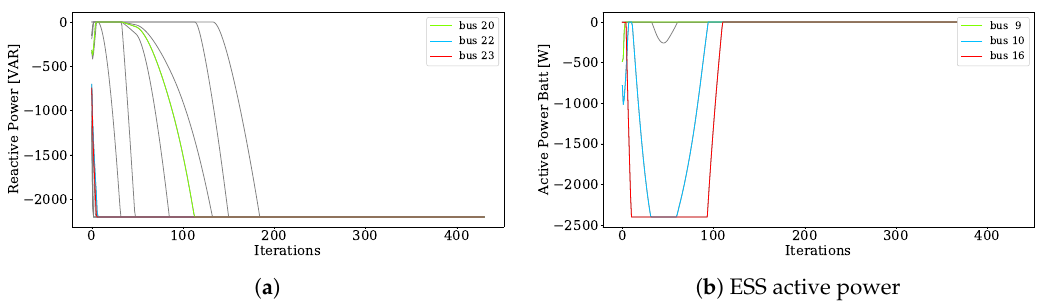
Figure 14. DG and ESS power injection in scenario without virtual nodes. ( a ) DG reactive power ( b ) ESS active power.